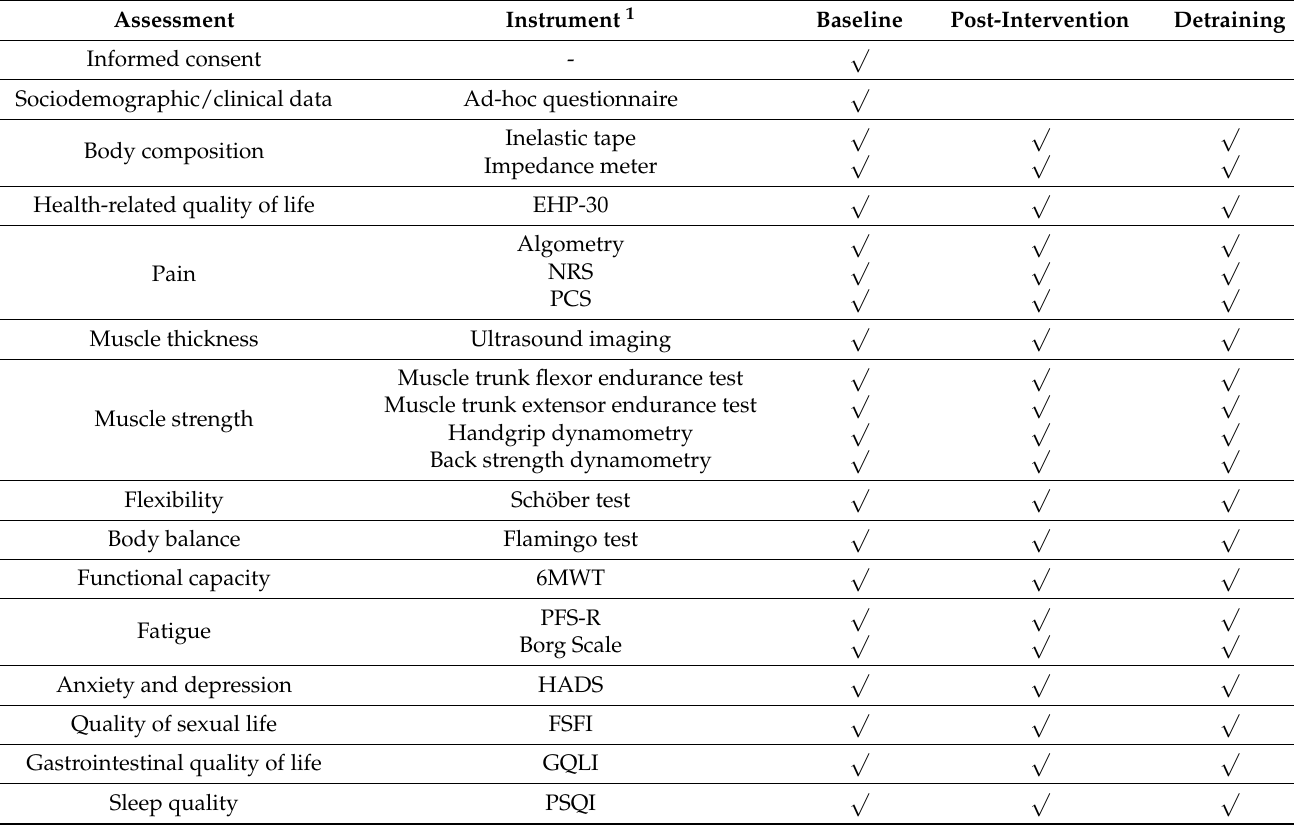
Table 2. ‘Physio-EndEA’ evaluation protocol